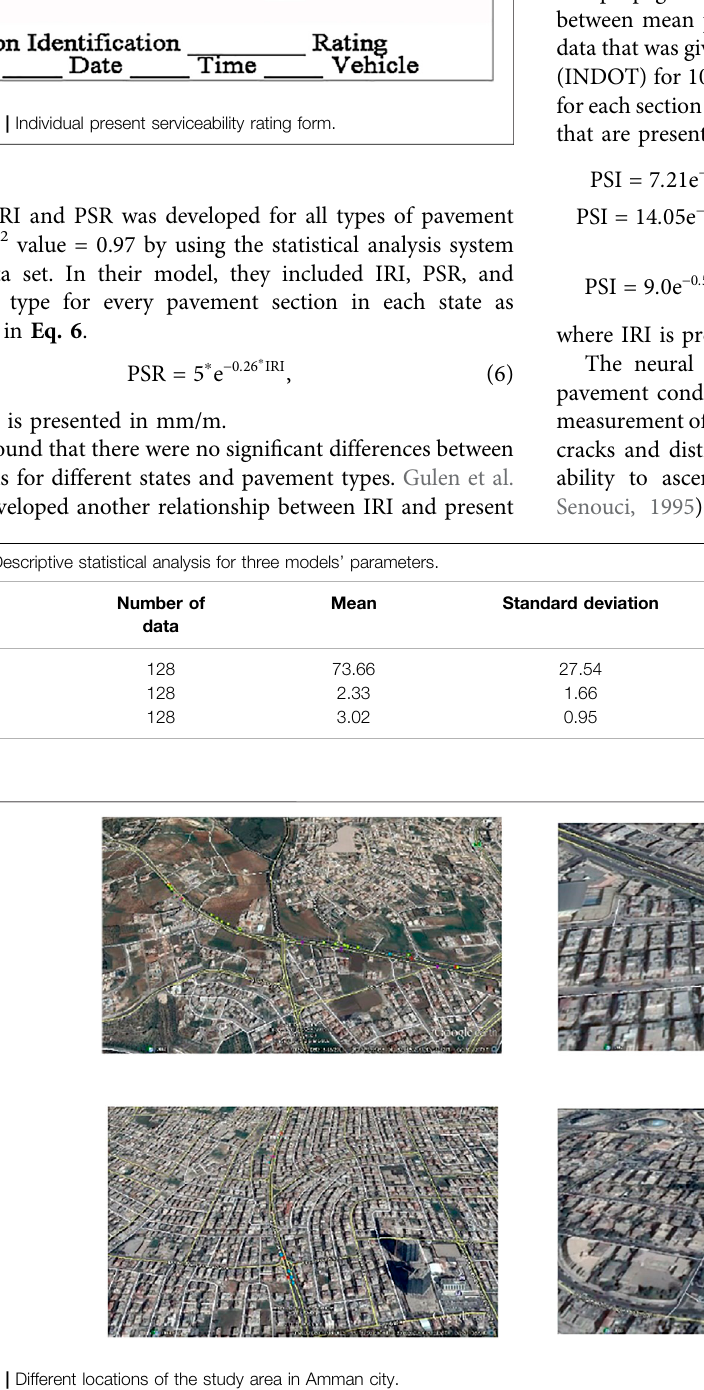
FIGURE 2 | Different locations of the study area in Amman city.